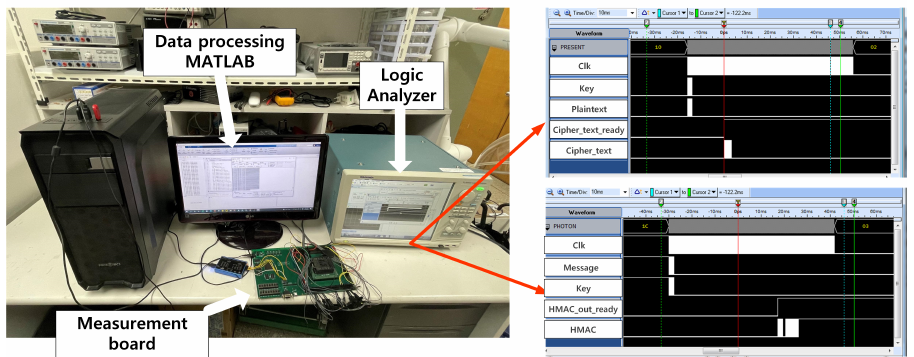
Figure 12. SoC measurement environment. MATLAB generated test vectors that were streamed to the measurement board, where the output results were displayed on the interface of the logic analyzer and were transmitted back to MATLAB in binary